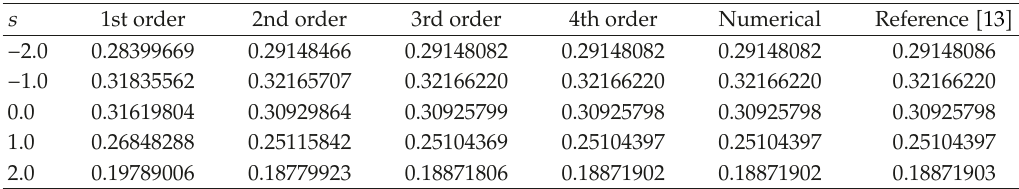
Table 3: Comparison of F (cid:4) (cid:6) 0 (cid:7) at di ff erent orders for the SLM approximations when L (cid:10) 20, N (cid:10) 60 against the results of (cid:3) 13 (cid:4) for di ff erent s values when m (cid:10)